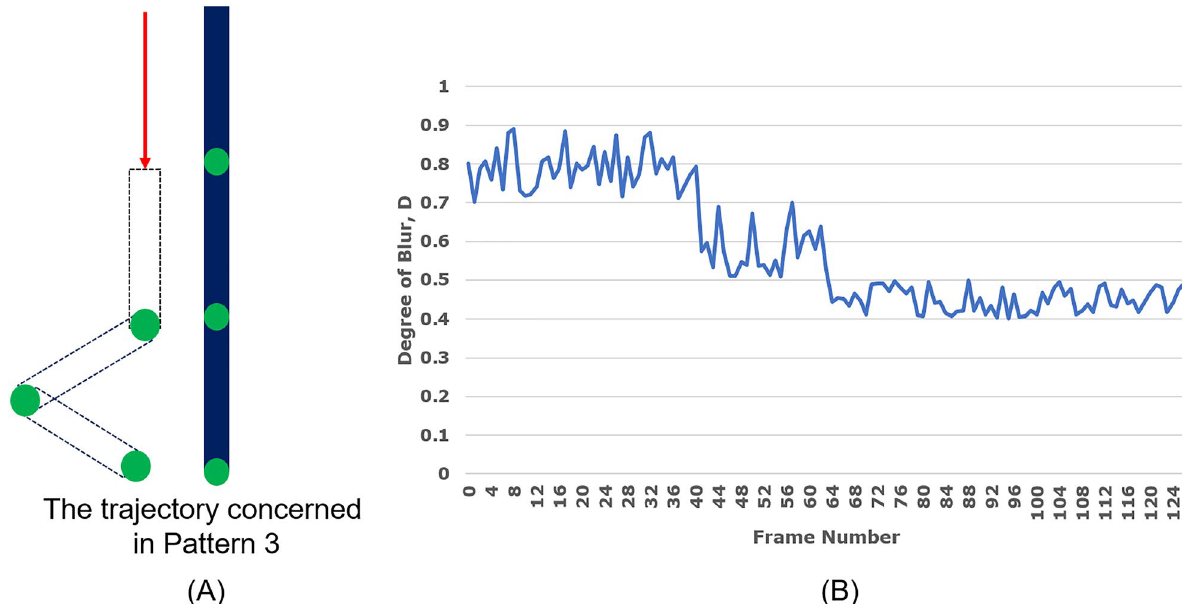
Fig. 7 The degree of blur evaluation result of Pattern 3. A The trajectory of Pattern 3. B The tendency of blurry degree D according to the frame number